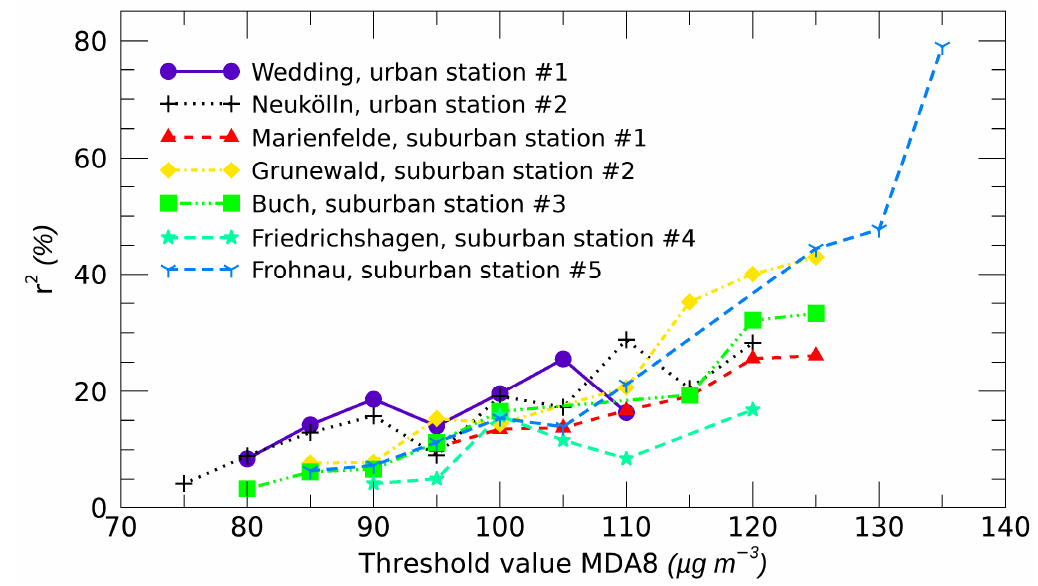
Figure 4. Comparison of the explained variance ( r 2 ) for all of the statistically highly significant ( p < 0.01)